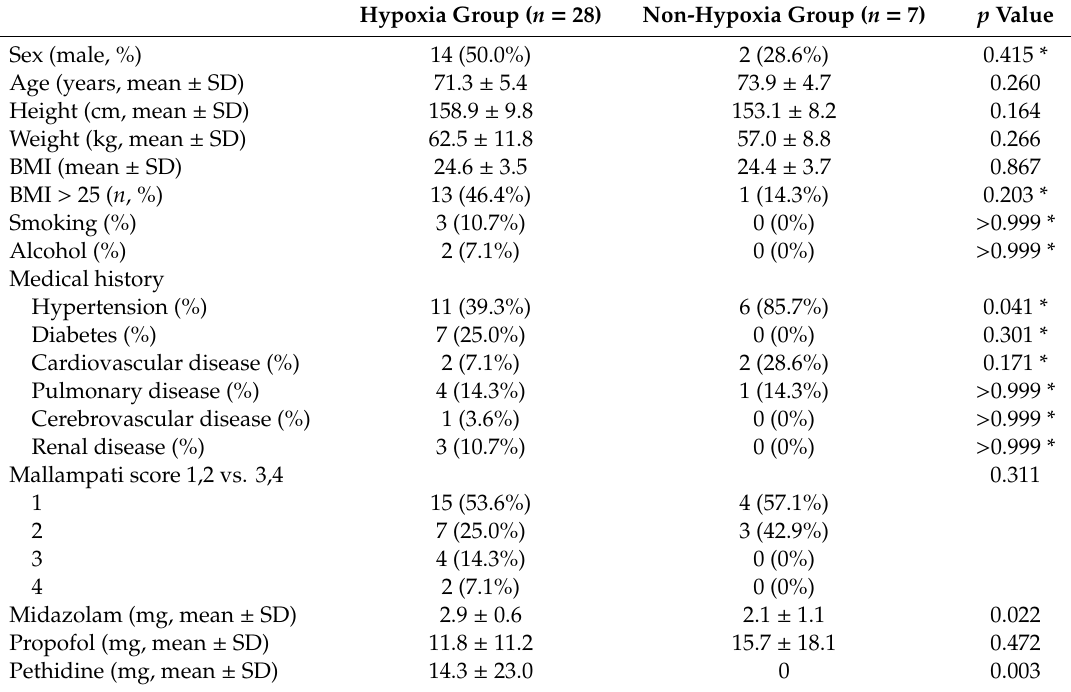
Table 4. Sub-group analysis of non-oxygenated group (n =